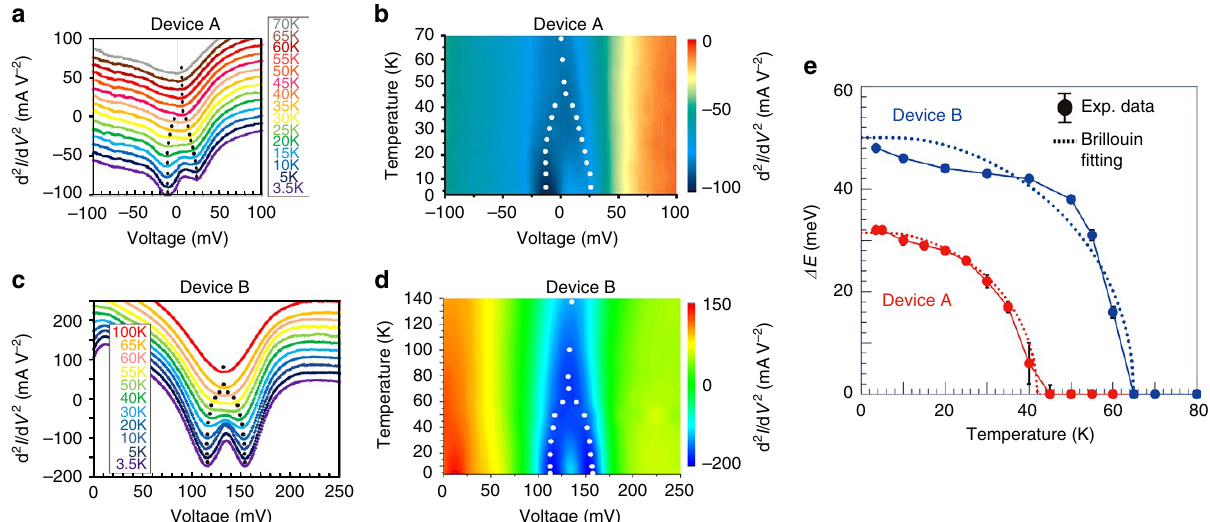
Figure 2 | Temperature dependence of the spontaneous spin-splitting energy of (In,Fe)As. ( a and c ) d 2 I /d V 2 – V characteristics of devices A and B, respectively, measured at various temperatures (the vertical axes are intentionally shifted for clear vision). ( b and d ) Colour plots of the data in a and c , respectively. White and black dots in a – d mark the centre positions of the valleys obtained by fitting two Lorentzian curves to the experimental d 2 I /d V 2 – V characteristics. ( e ) Temperature dependence of spin-splitting energy D E in devices A (red circles) and B (blue circles) and their Brillouin-function fitting curves (dotted red and blue curves for devices A and B,